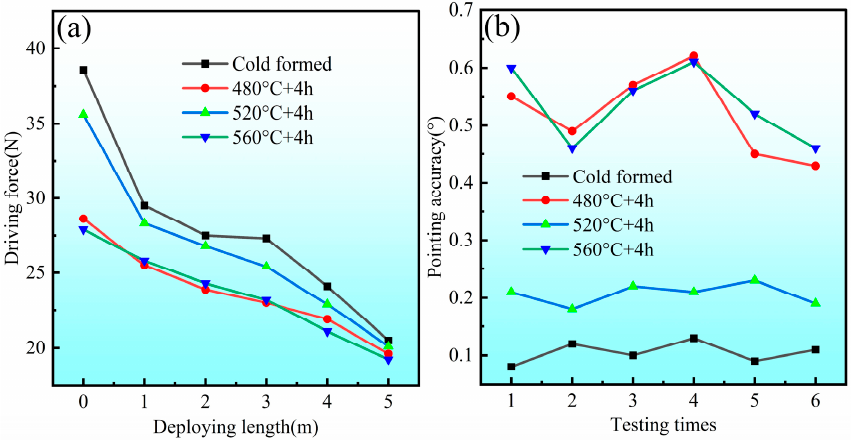
Figure 7. Typical service performances for CSPB STACER (cold formed) and winding and stabilization STACER: ( a ) driving force; ( b ) pointing accuracy. Table 3. Data of driving force and pointing accuracy for CSPB STACER and winding and stabilization STACER.